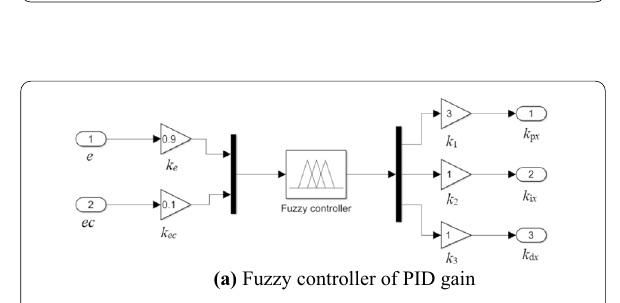
Figure 7 Output surfaces of k p x , k i x , and k d x